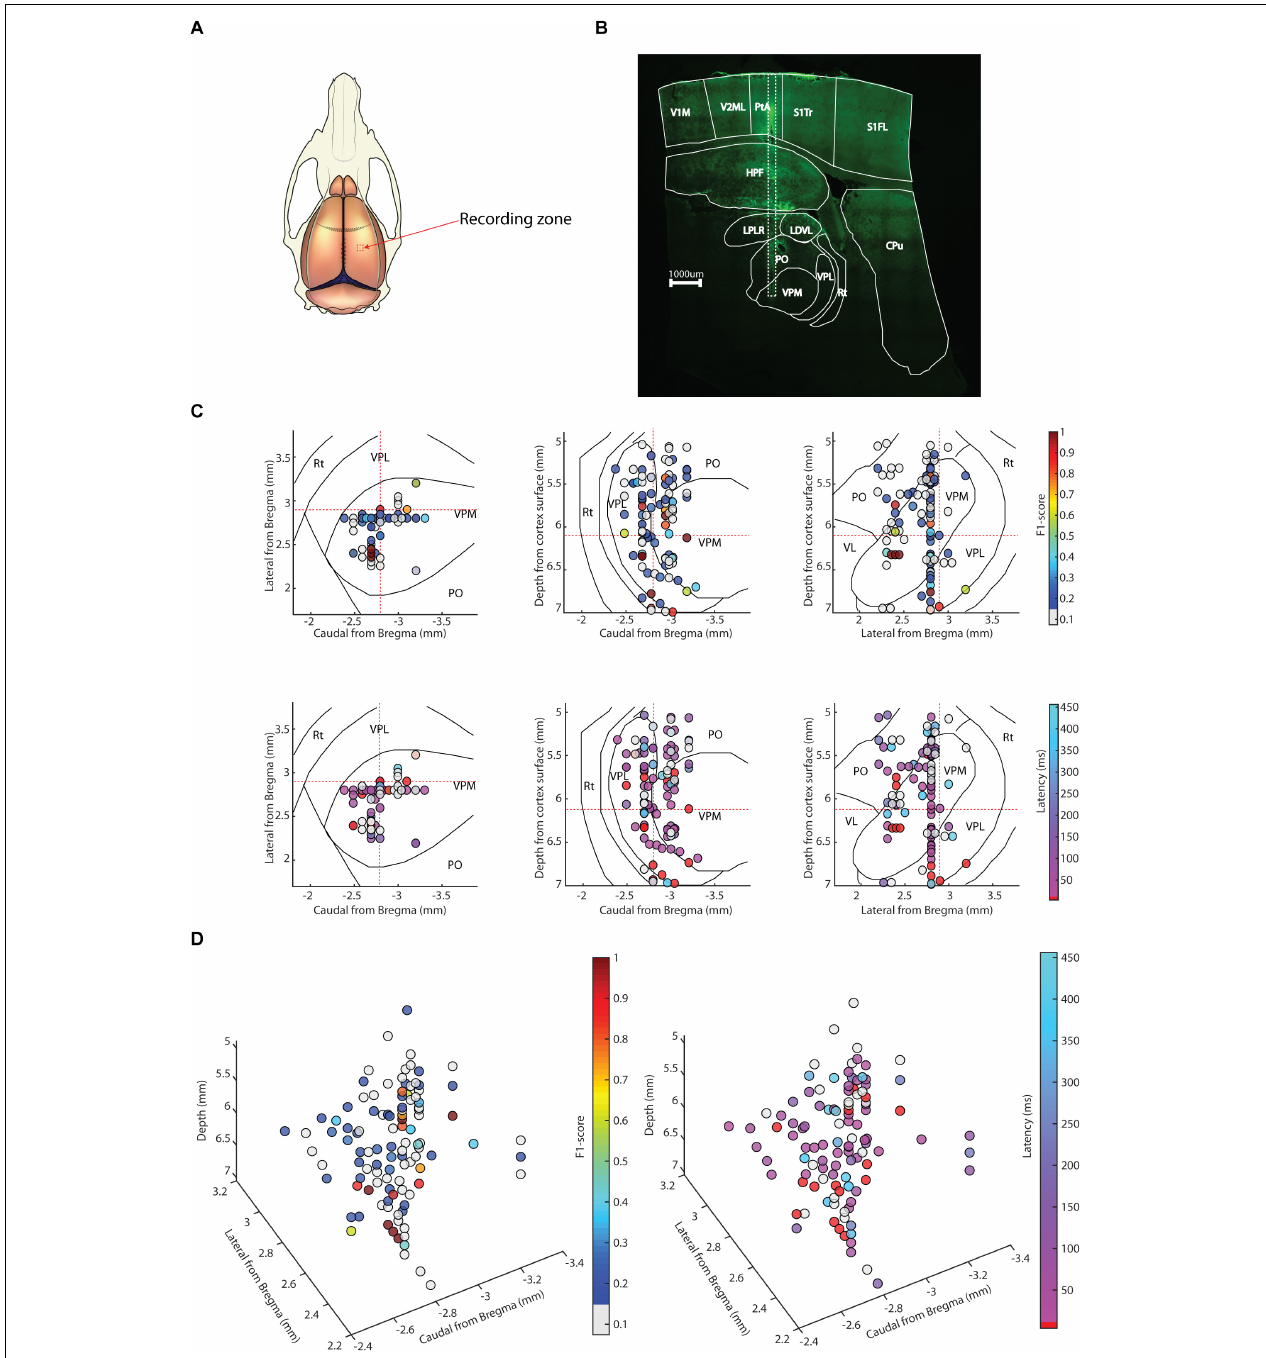
FIGURE 5 | Relationships between location and decoding level and response latency time. (A) Schematic of the recording area from a dorsal view. (B) Sagittal section of the brain (with the thalamic nuclei outlined according to Paxinos and Watson, 2006) illustrating one electrode track (white dotted box). (C) 3D location of thalamic neurons visualized in three viewing directions, mapped onto one plane each (horizontal 6.3 mm, sagittal 2.9 mm and coronal –2.8 mm; more precise locations displayed in Figure 2 ) with color coded decoding performance (top row of plots) and response latency times (bottom row of plots). Response latency times of 10 ms or lower have been colored red. Dotted red lines in each plot indicate the stereotactic planes in the other two plots, for reference. (D) Similar display as in (C) but as 3D projections, with decoding performance shown to the left and response latency times to the right. Note that for visualization, multiple neurons recorded during the same recording session and electrode have been shifted 40 µ m in the mediolateral axis, and neurons recorded very closely to each other according to stereotaxic coordinates, but in different sessions, have been shifted 40 µ m in the rostrocaudal axis. V1, primary visual cortex; V2, secondary visual cortex; HPF, hippocampal formation; PtA, parietal area; S1, primary somatosensory cortex; CPu, caudate putamen (striatum); LPLR, lateroposero laterorostral nucleus; LDVL, laterodorsal ventrolateral nucleus.